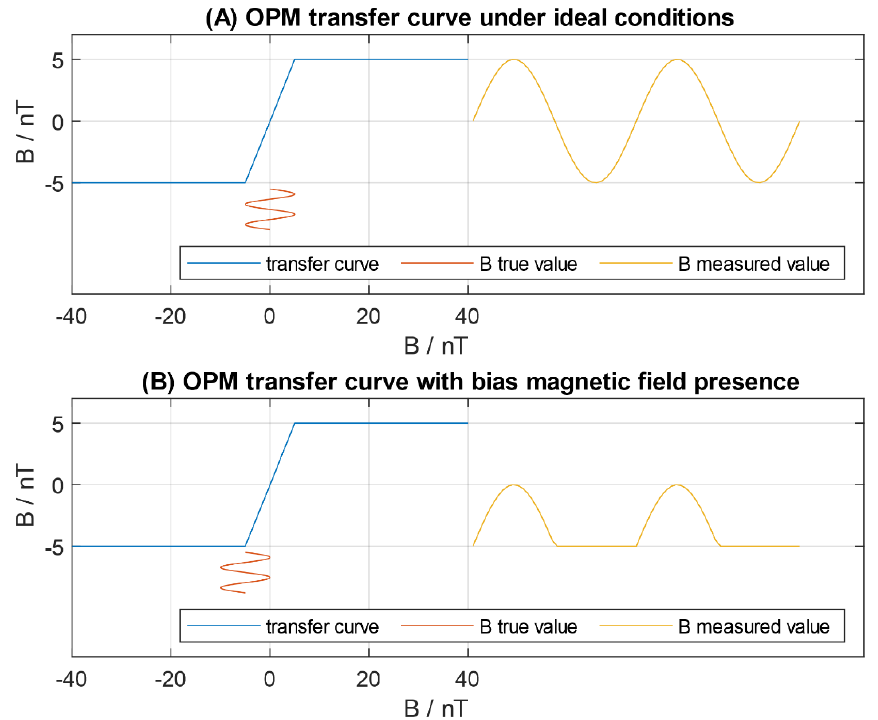
Figure 1. Conceptual transfer curve of the zero-field optically pumped magnetometer electronic module output: ( A ) under ideal conditions; (B) with the presence of the bias magnetic field. In ( B ), signal saturation is visible.